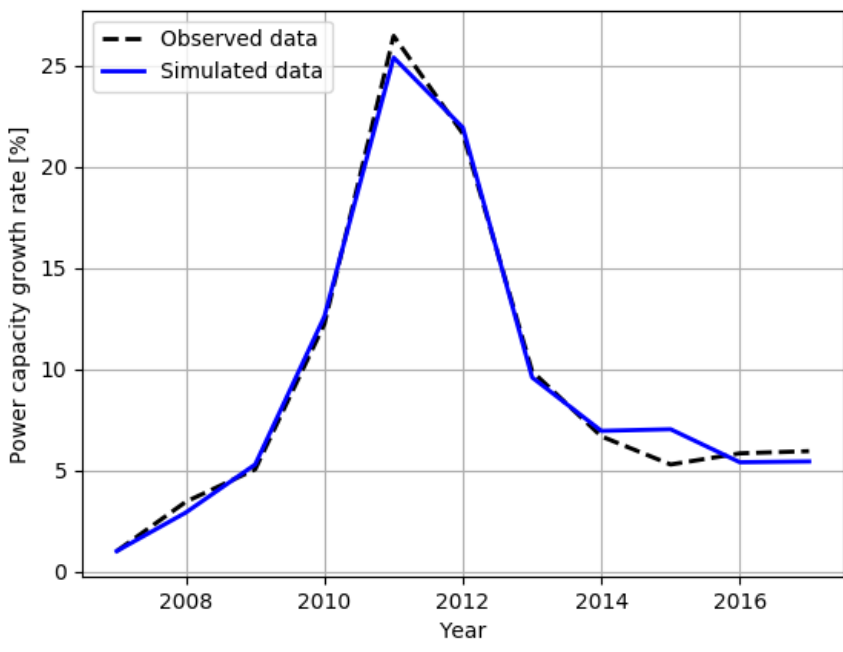
Figure 2. Model calibration results—yearly installed photovoltaic (PV)